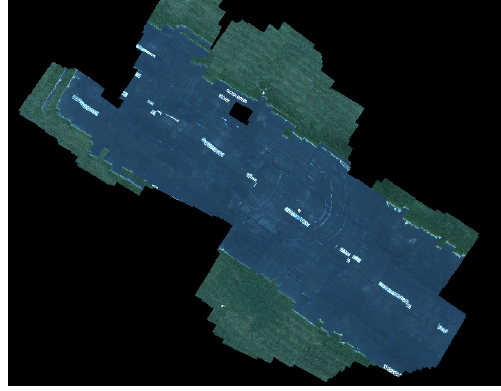
Figure 15. Successful assembly of image of runway showing a more normal result. Note this figure is not at the same scale as Figure